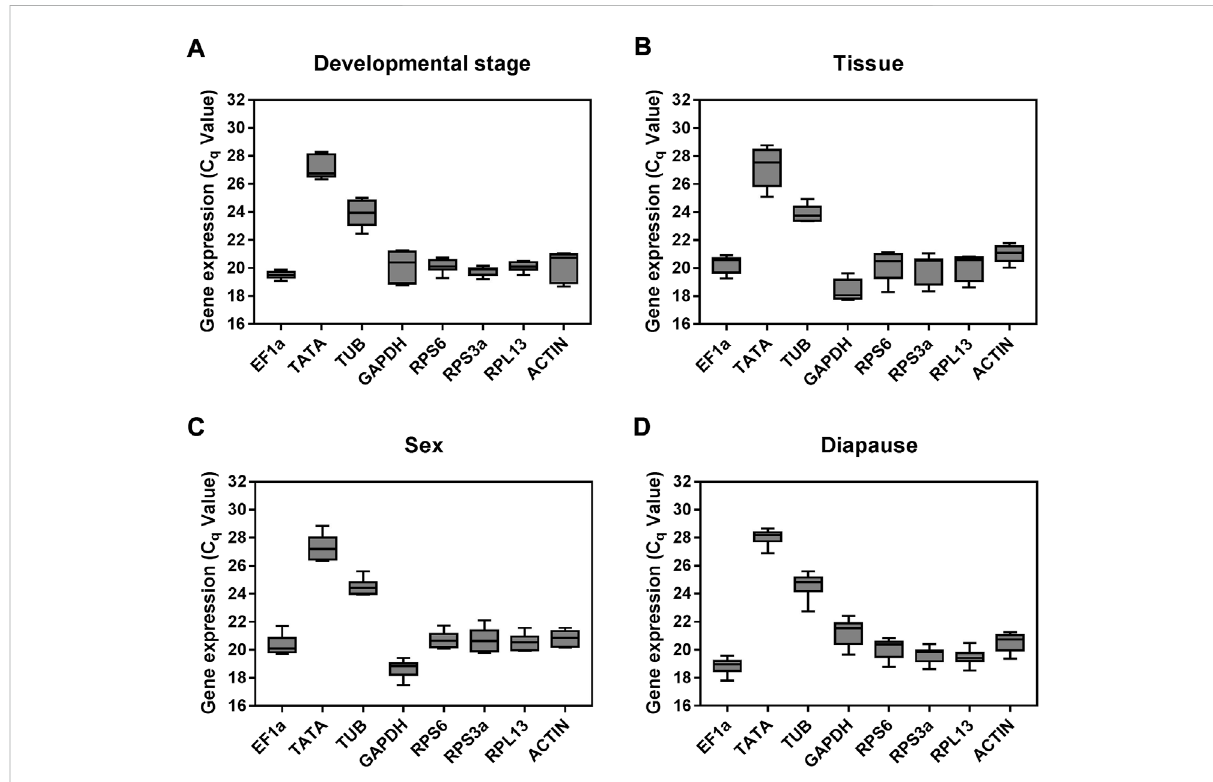
FIGURE 2 Expression pro fi les of the eight candidatereferencegenes in all four experiments for A. japonicus . The expression levels of the reference genes are shown in terms of the Cq-value for each experimental condition. (A) Development stage, (B) Tissue, (C) Sex, (D) Diapause